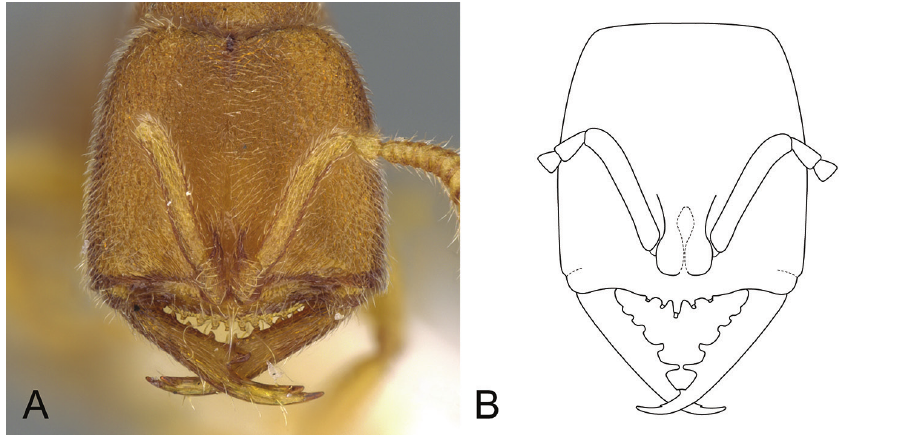
Figure 9. Stigmatomma pertinax and S. caliginosum . A Holotype of S. pertinax (CASENT0906831); worker; full-face view. Image by Michele Esposito; available at AntWeb.org B S. caliginosum ; worker; full-face view. Illustration by